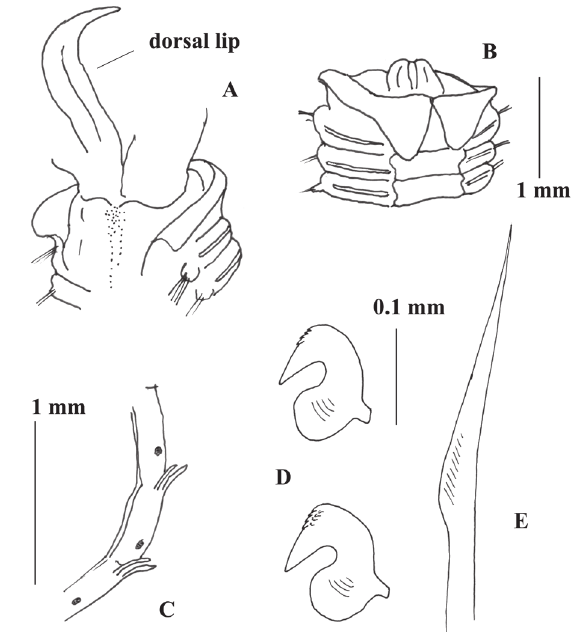
Fig . 5. – Branchiomma cf. moebii : A, anterior end, dorsal view; B, anterior end, ventral view; C, detail of radiole, showing stylodes and radiolar eyes; D, thoracic uncini in different views; E, thoracic inferior